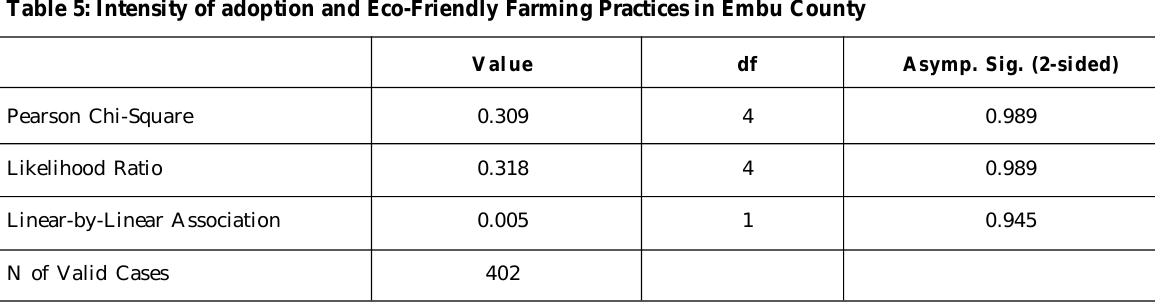
Table 5: Intensity of adoption and Eco-Friendly Farming Practices in Embu County Value df Asymp. Sig. (2-sided) Pearson Chi-Square 0.309 4 0.989 Likelihood Ratio 0.318 4 0.989 Linear-by-Linear Association 0.005 1